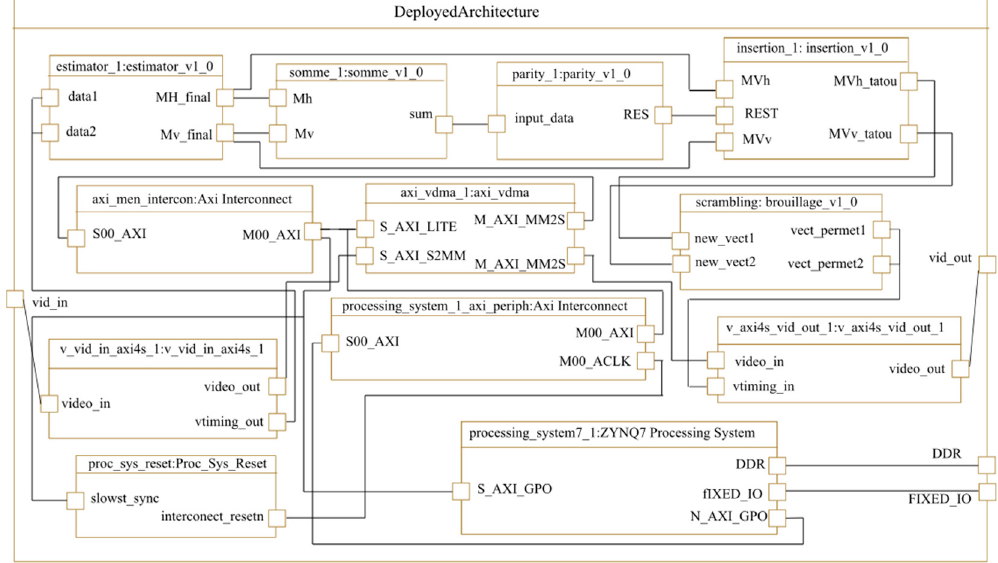
Figure 16. The deployed